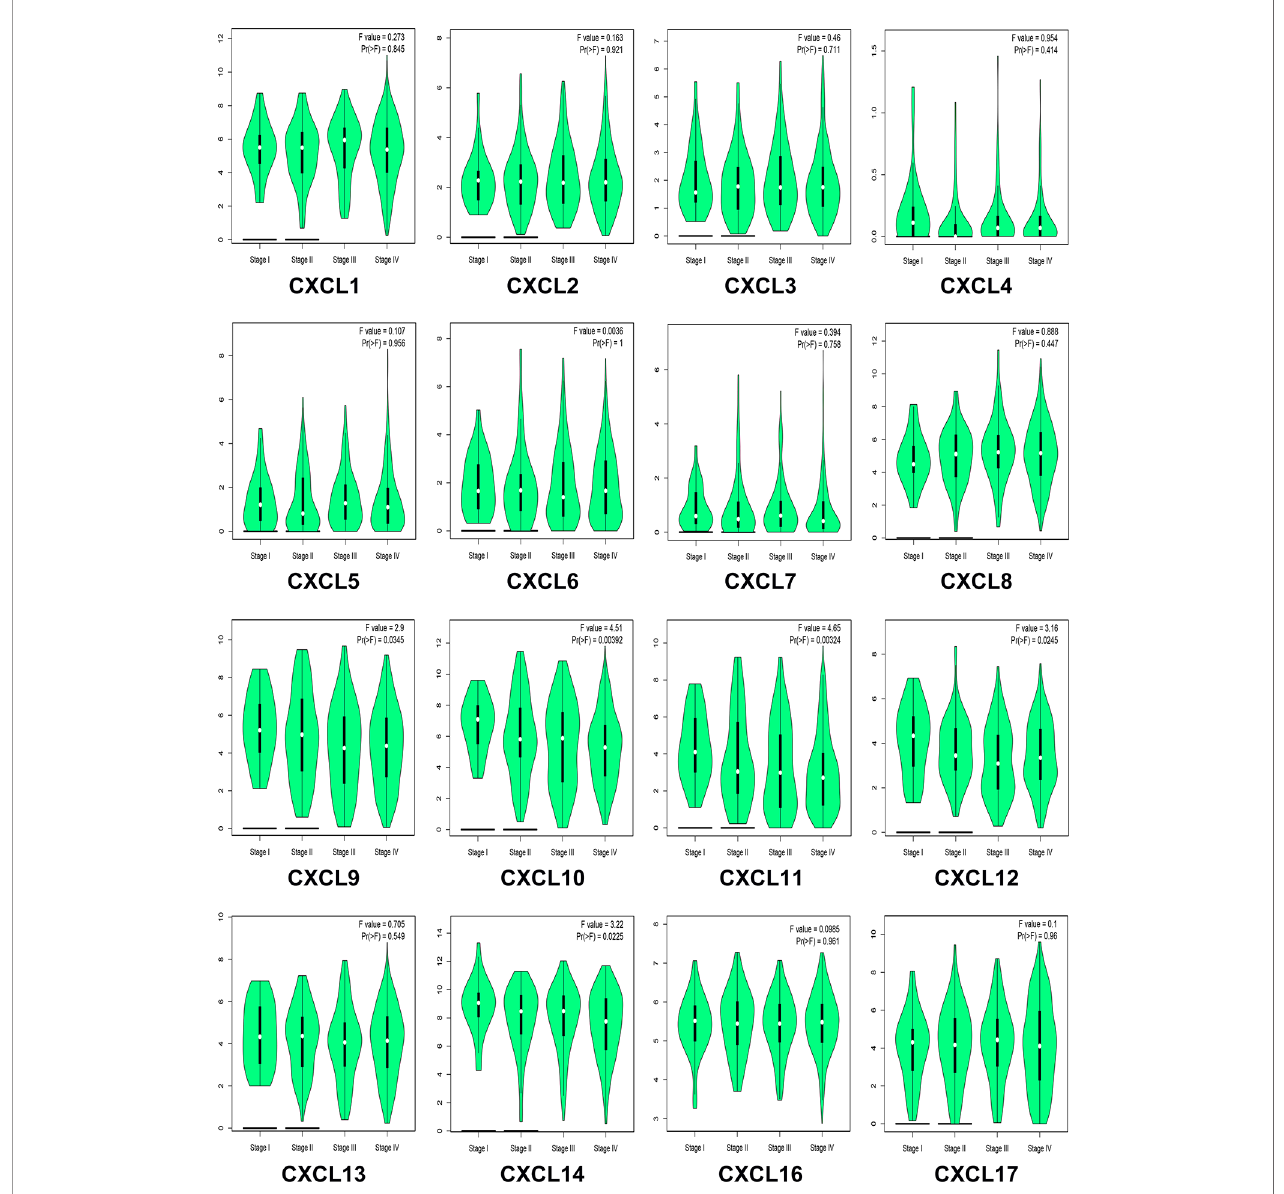
FIGURE 3 | Correlation between CXC chemokines expression and tumor stage in HNSCC patients (GEPIA). the p -value was set